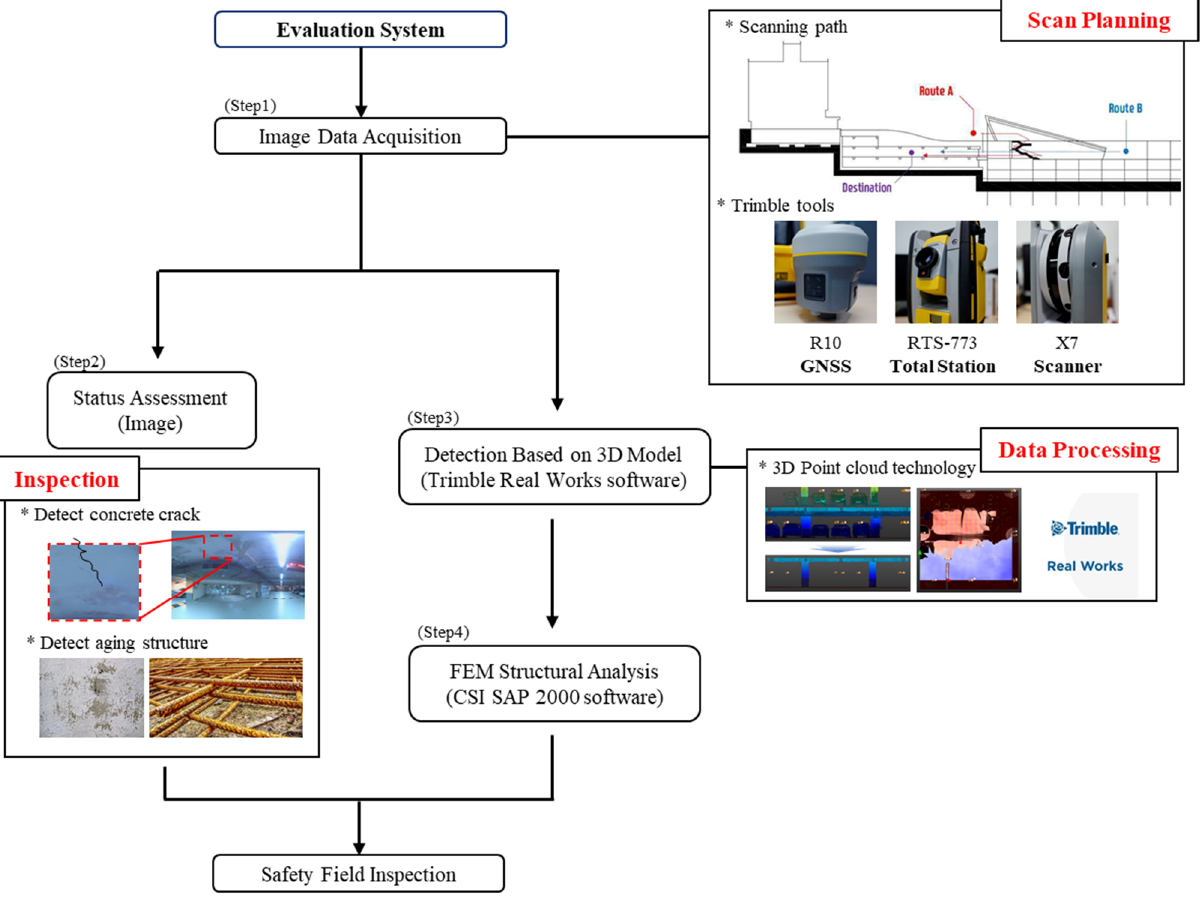
Figure 2. The process of structural evaluation system using 3D laser scanner.